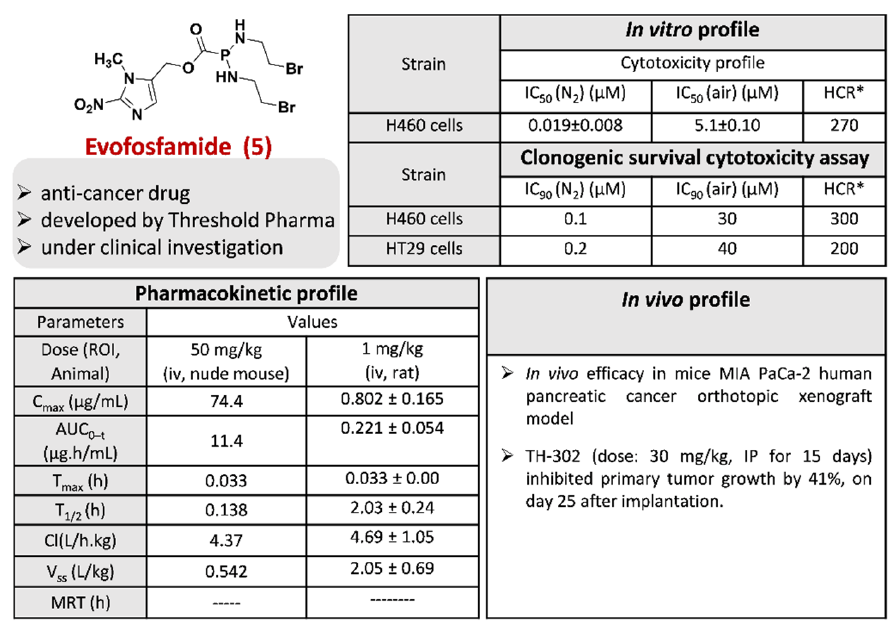
Figure 8. Activity profile of Evofosfamide 5 [67–70]. *: Hypoxia cytotoxicity ratio (HCR) was determined by the differential cytotoxicity under normoxic and hypoxic conditions: HCR=IC 50 (air)/IC 50 (N 2 ).